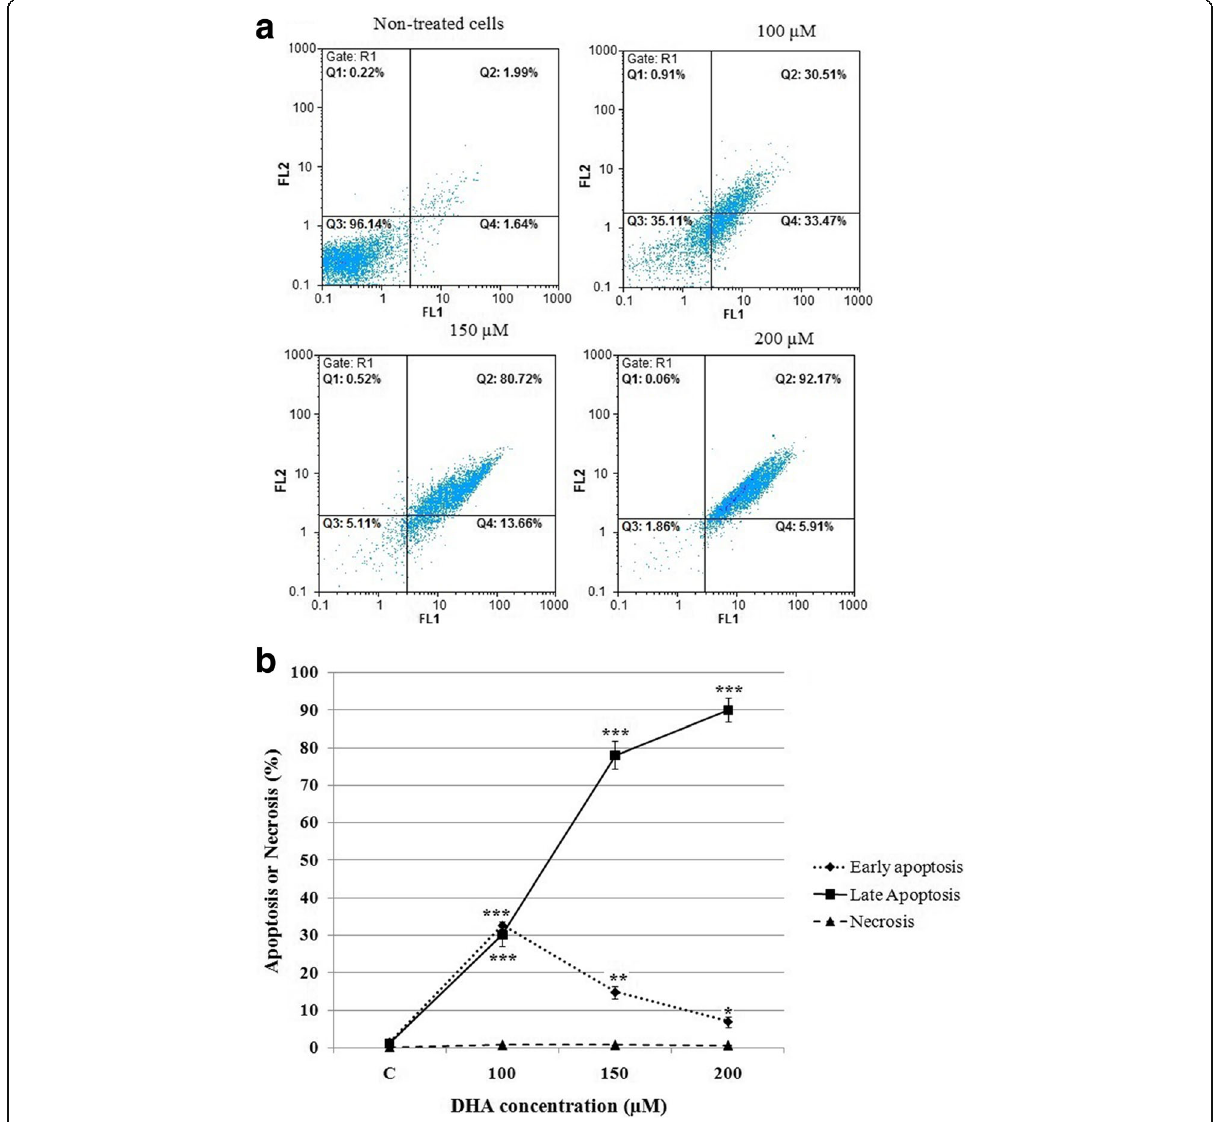
Fig. 7 Effect of DHA on apoptosis induction. 5×10 5 HCT-116 cells per well were treated with various concentrations of DHA for 48 h, after which apoptosis was measured using flowcytometer. a FL1: Annexin V-FITC (horizontal axis) and FL2: PI (vertical axis). (Q1) pre-necrotic cells, (Q2) late apoptosis, (Q3) live cells, and (Q4) early apoptotic cells. b Histogram presentation of apoptotic cell percentages * P <0.05, ** P <0.01, and *** P <0.001 vs. untreated control cells